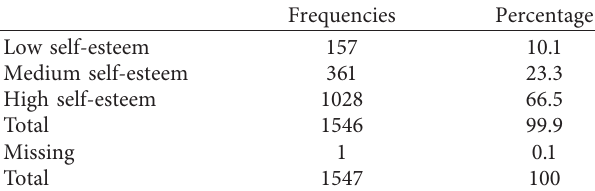
Table 2: Descriptive results according to levels of